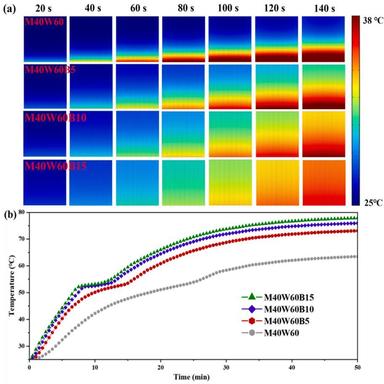
(a) 2D finite element simulation diagram of TIMs; (b) the time–temperature curve of the upper surface of TIMs.